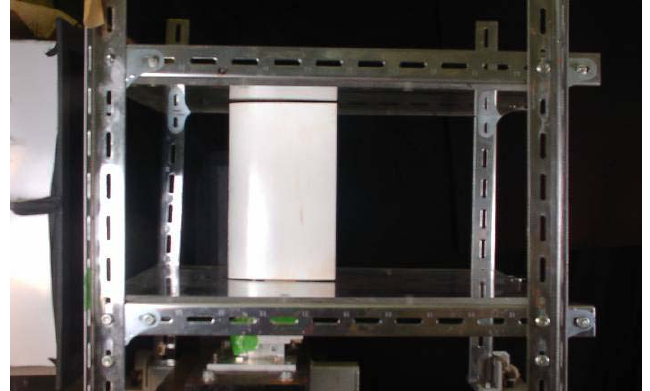
Fig.5 Experimental